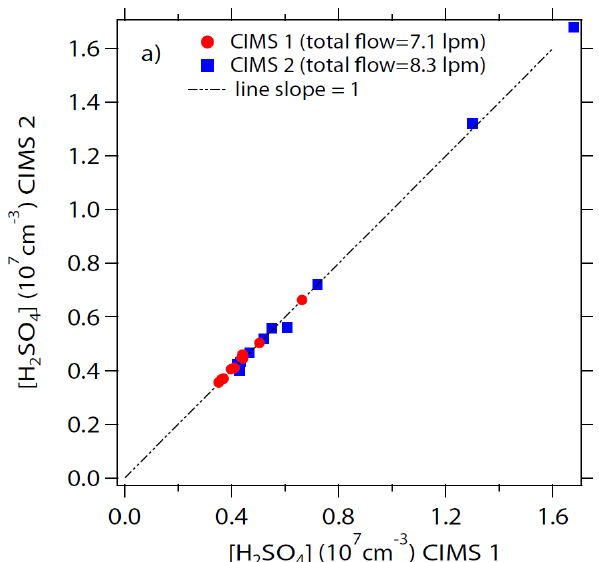
Fig. 2a. The measured [ H 2 SO 4 ] with two CIMSs at the beginning Figure 2a. The measured [ H 2 SO 4 ] with two CIMSs at the beginning of the nucleation reactor. 620 of the nucleation reactor. RH=14%. Dashed line shows the linear fitting of the RH = 14%. Dashed line shows the linear fitting of the data. 621